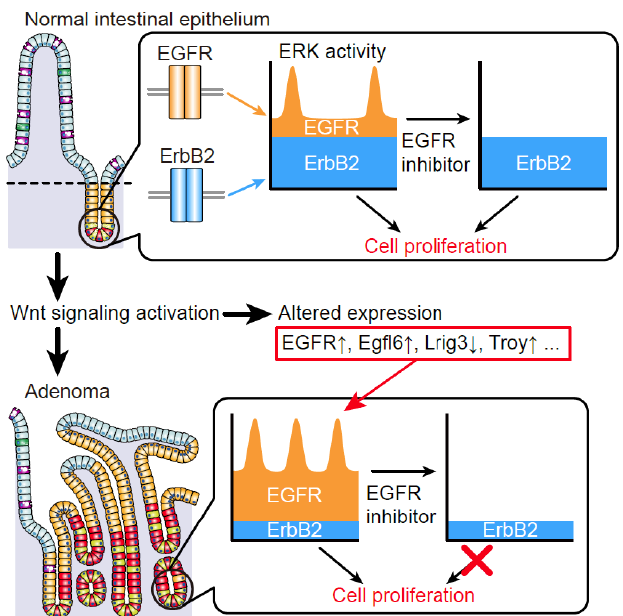
Figure 2. ERK activity dynamics in intestinal homeostasis and tumorigenesis. In the normal intestinal epithelium, ERK signaling dynamics are defined by EGFR-dependent pulsatile activity and ErbB2-dependent basal activity. During intestinal tumorigenesis, deregulated activation of Wnt signaling induces alterations in the expression levels of EGFR and its regulators, thereby enhancing EGFR signaling. The enhancement of EGFR signaling increases frequency of ERK activity pulses and promotes cell proliferation. At the same time, contribution of EGFR signaling to basal ERK activity is increased in tumor cells, which renders cells highly dependent on EGFR signaling. Thus, in the intestinal epithelium, tumor cells are more susceptible for pharmacological inhibition of EGFR signaling than normal cells.